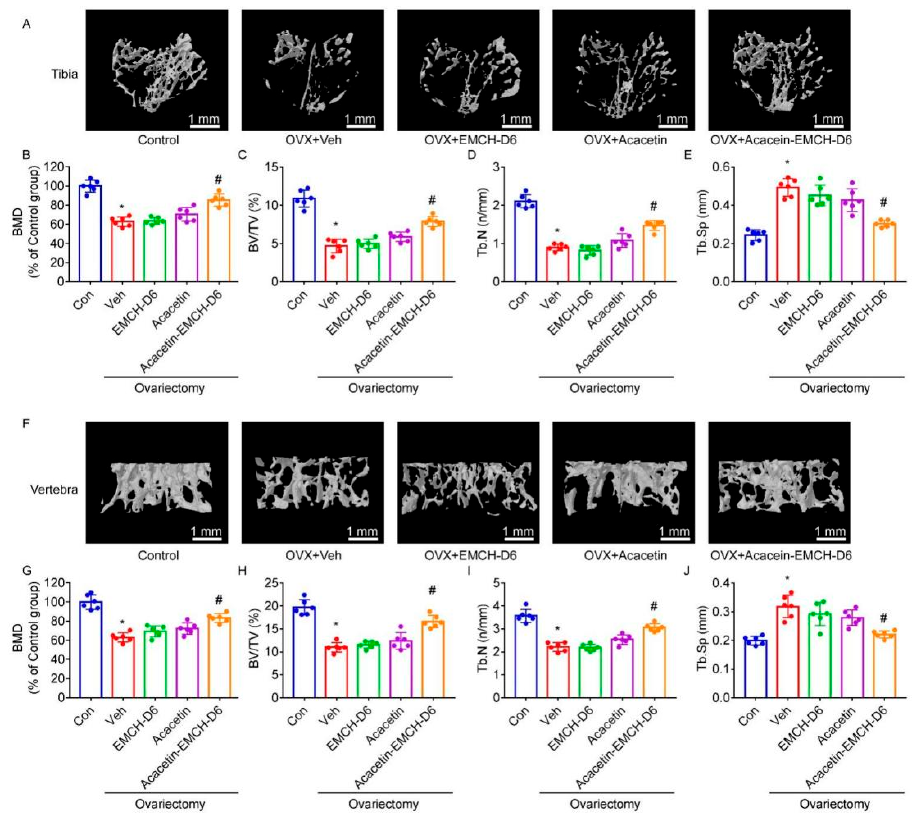
Figure 4. One week after surgery of ovariectomy (OVX), mice were treated with Acacetin-EMCH- D6 or acacetin (i.p., 17.5 μ mol/kg/3 days) for 5 weeks. Left tibia and L5 vertebra were subjected to micro-CT scanning. Representative three-dimensional reconstructed images were presented ( A , F ). Trabecular structural parameters of proximal tibia and vertebrae including BMD ( B , G ), BV/TV ( C , H ), Tb.Th ( D , I ), Tb.N ( E , J ) were presented. * p < 0.05 versus the control group; # p < 0.05 versus the vehicle-treated OVX group, n =